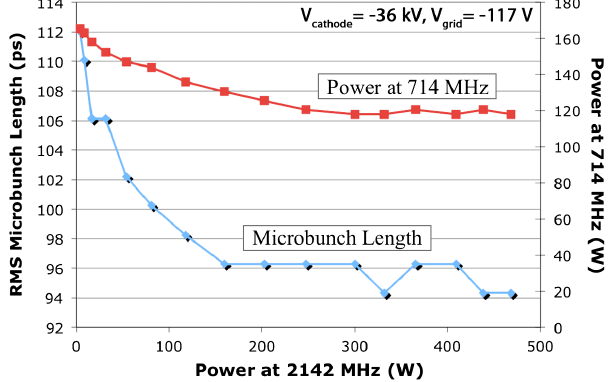
FIG. 8. The rms bunch length and first harmonic power versus third harmonic power at 0.6 A peak microbunch current.